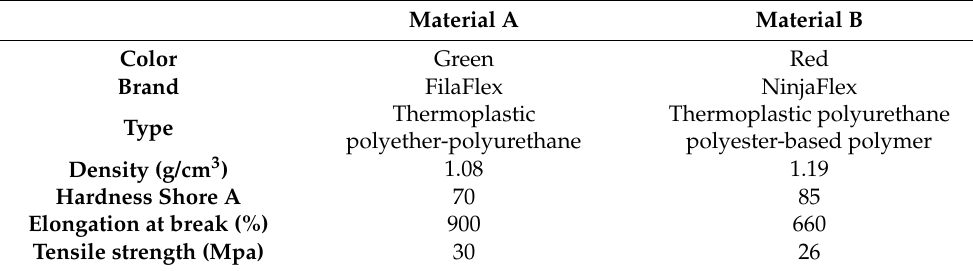
Table 1. Material comparison.